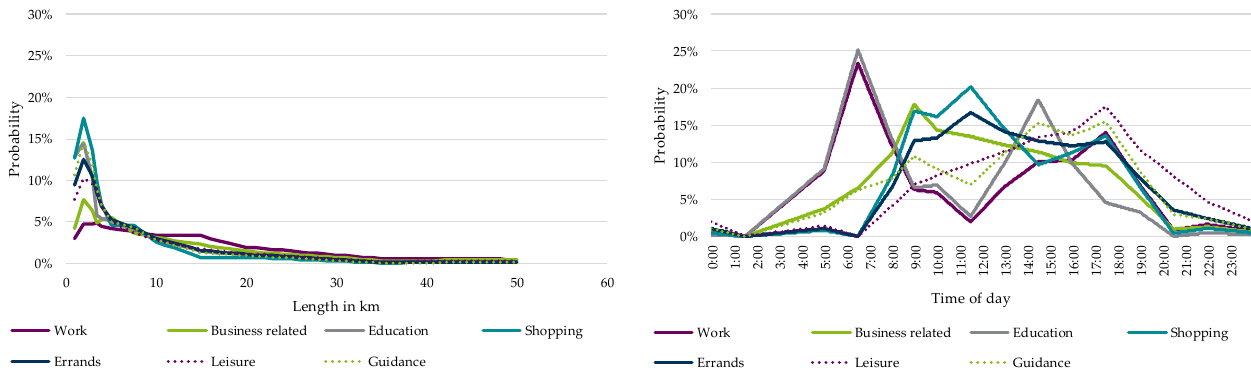
Figure A1. Left : Probability distribution of the length of the routes per vehicle according to the purpose of the route. Right : Probability distribution of the time of departure of a vehicle according to the purpose of the route based on data published in [27] for “Urban Region: Regiopolis, Large City”.